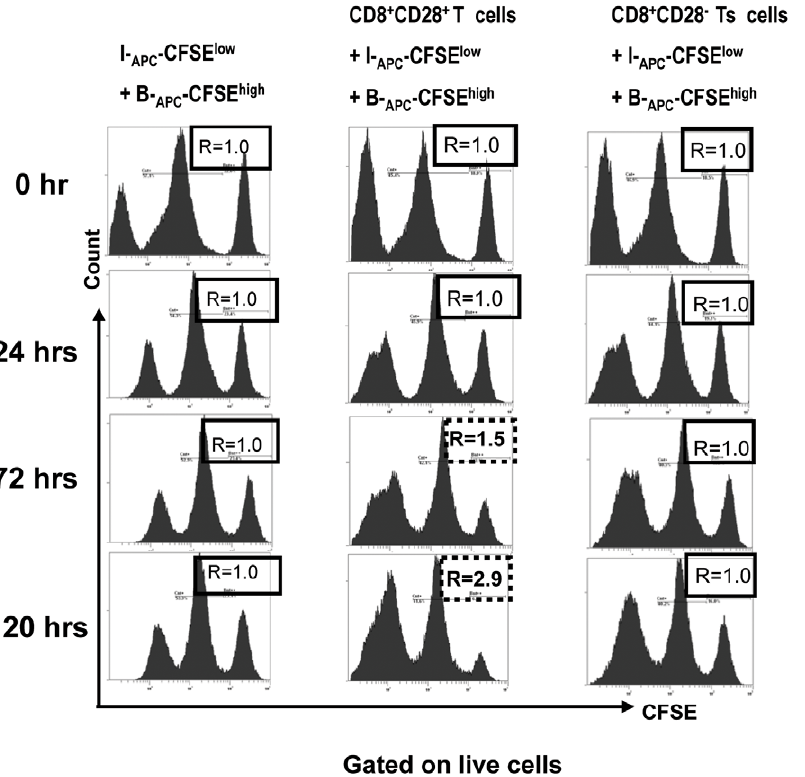
Figure 5. Cytotoxicity does not contribute to the suppression of proliferation by the invitro expanded CD8 + CD28 2 T cells. A CFSE based cytotoxicity assay was set up as follows: target cells were the original priming APCs (for generating the CD8 + CD28 2 T cells) labeled with a high concentration (2.0 m M) of CFSE (B- APC -CFSE high ), or APCs from an HLA-A, -B, and -DR mismatched indifferent individual labeled with a low concentration (0.2 m M) of CFSE (I- APC -CFSE low ). A 1:1 mixture of I- APC -CFSE low and B- APC -CFSE high cells were plated either by themselves (left panels), or with the same number of control (CD8 + CD28 + , middle panels) or putative (CD8 + CD28 2 , right panels) effector cells in 96 U-bottom plates in triplicates. At 24, 72, and 120 hr of culture, cells were collected and analyzed by FACS to enumerate CFSE low and CFSE high cells. The ratio of cell numbers of I- APC - CFSE low over B- APC -CFSE high was calculated as ‘‘R’’ for all time points. An increase in the value of R indicates specific killing of B- APC -CFSE high cells by the effector cells, whereas a stable value of R at 1.0 indicates no specific killing of B- APC -CFSE high cells by the effector cells. Data shown are representative of two independent experiments.